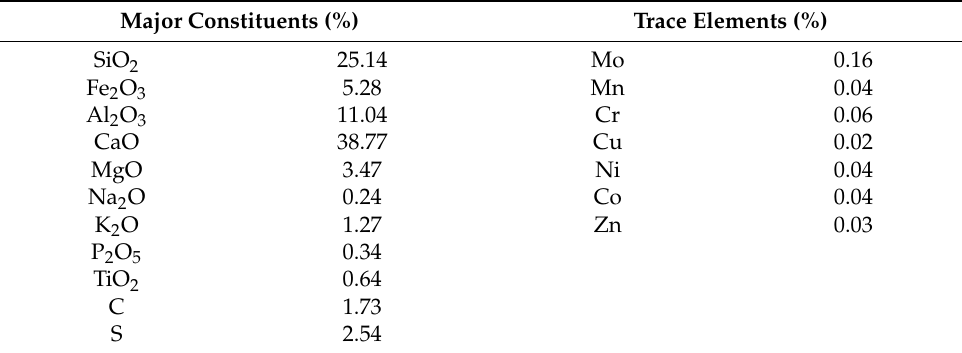
Table 1. Chemical analysis of the representative fly ash sample. Major Constituents (%) Trace Elements (%) SiO 2 25.14 Mo 0.16 Fe 2 O 3 5.28 Mn 0.04 11.04 0.06 CaO 38.77 Cu 0.02 MgO 3.47 Na 2 O